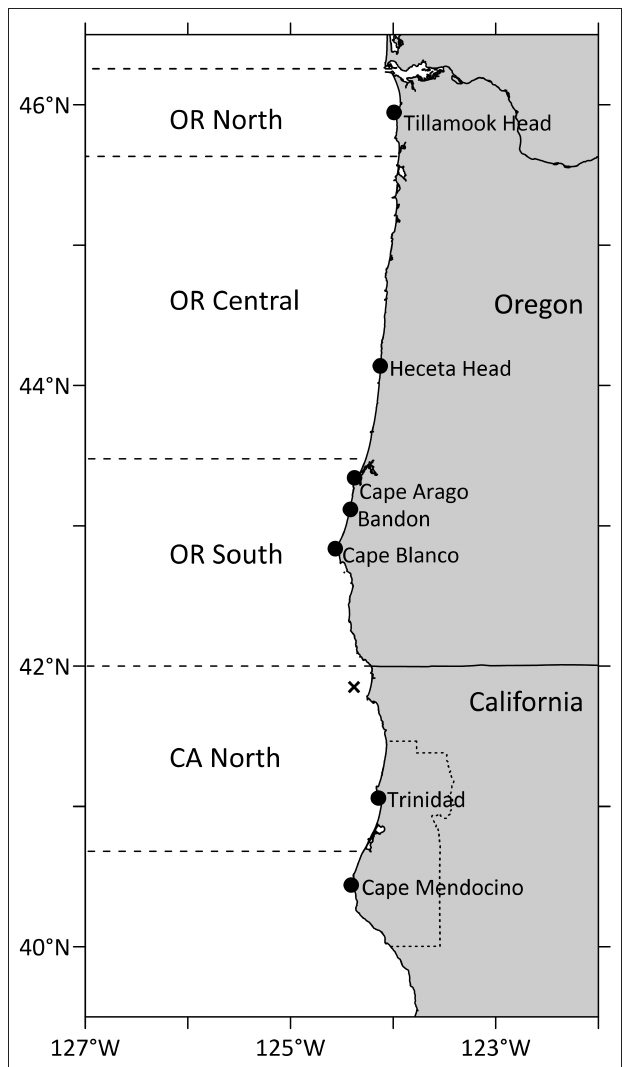
Table 1 . Humboldt County, CA, is shown as a dotted line on land. The location of buoy 46027-6, from which wind data in Figure 3 were retrieved, is shown with an